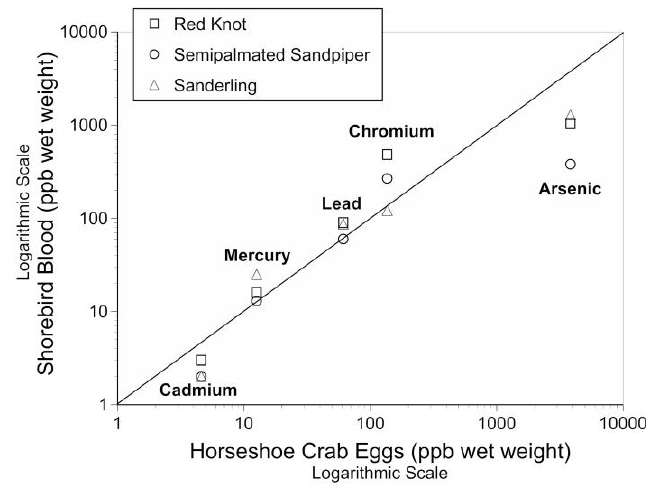
Figure 2. Relationship of mean levels of arsenic, cadmium, chromium, lead and mercury in the blood of three species of shorebirds and the mean level in eggs of horseshoe crabs, their primary prey while on migratory stopover in May at Delaware Bay, New Jersey. (See Table 1).